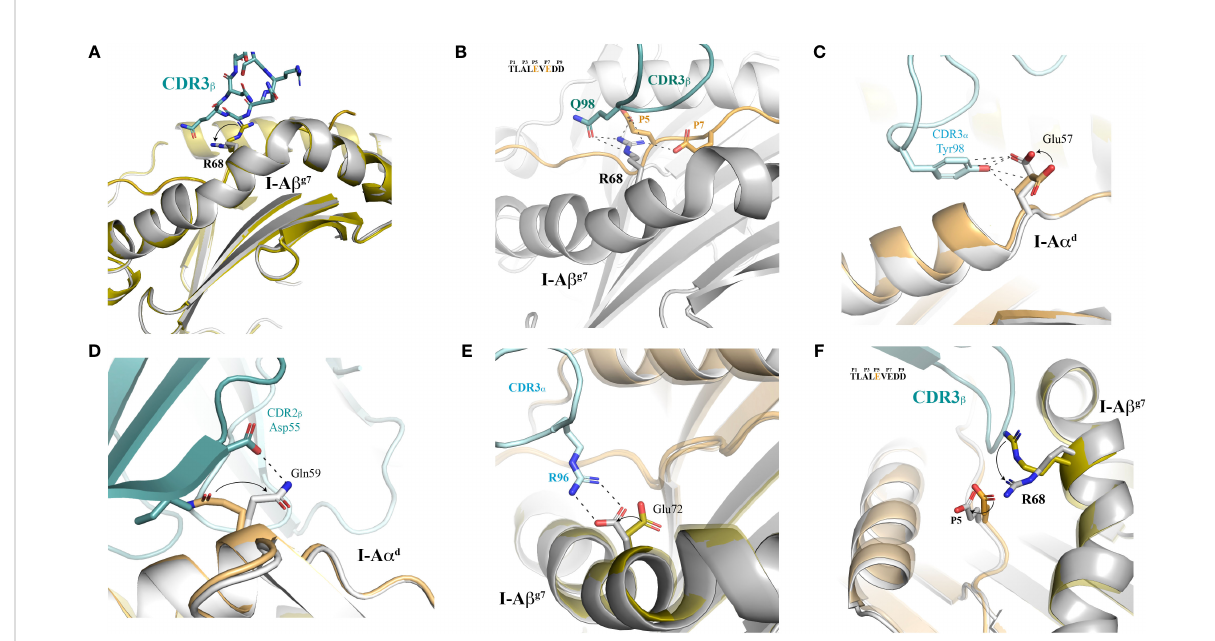
FIGURE 6 Structural plasticity of both I-A g7 and peptide contribute to 4.1-TCR docking. (A) The MHC platform is displayed in cartoon mode and both the free and TCR-bound I-A g7 molecules are aligned and superimposed to one another. The TCR-bound MHC is shown in grey color. The 4.1 CDR3 b is shown as sticks. (B) H-bonds and salt bridges between I-A b g7 Arg68, the 4.1-TCR and the HIP are highlighted with dashed lines. The sequence of the HIP is shown as an inset, with the interacting residues highlighted in orange color. (C – E) Structural motions observed in Glu57 in I-A a d and contacts established with the CDR3 a Tyr98 (C) . Structural transition in the I-A b g7 Gln59 side chain and polar contacts made with the TCR CDR2 b Asp55 side chain (D) . The presence of the TCR Arg96 in the CDR3 a is concomitant with a structural motion of I-A b g7 Glu72 that enables a closer and stronger salt bridge (panel E) between the two proteins. (F) Sequential transitions of Arg68 and HIP (Glu5) in the presence of 4.1-TCR. In all cases, structural motions are indicated with arrows, and go from the TCR-free to the TCR-bound